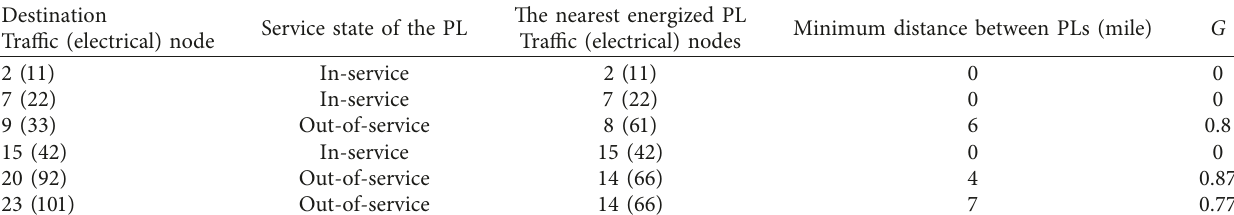
Figure 13: Convergence rate of the genetic algorithm for the proposed model in case 3. Table 6: Changing the out-of-service destinations PLs in case